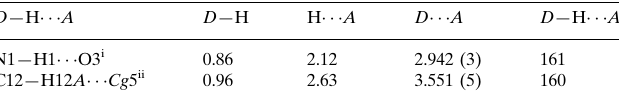
Hydrogen-bond geometry (A˚ , (cid:2) ). D —H (cid:3)(cid:3)(cid:3)